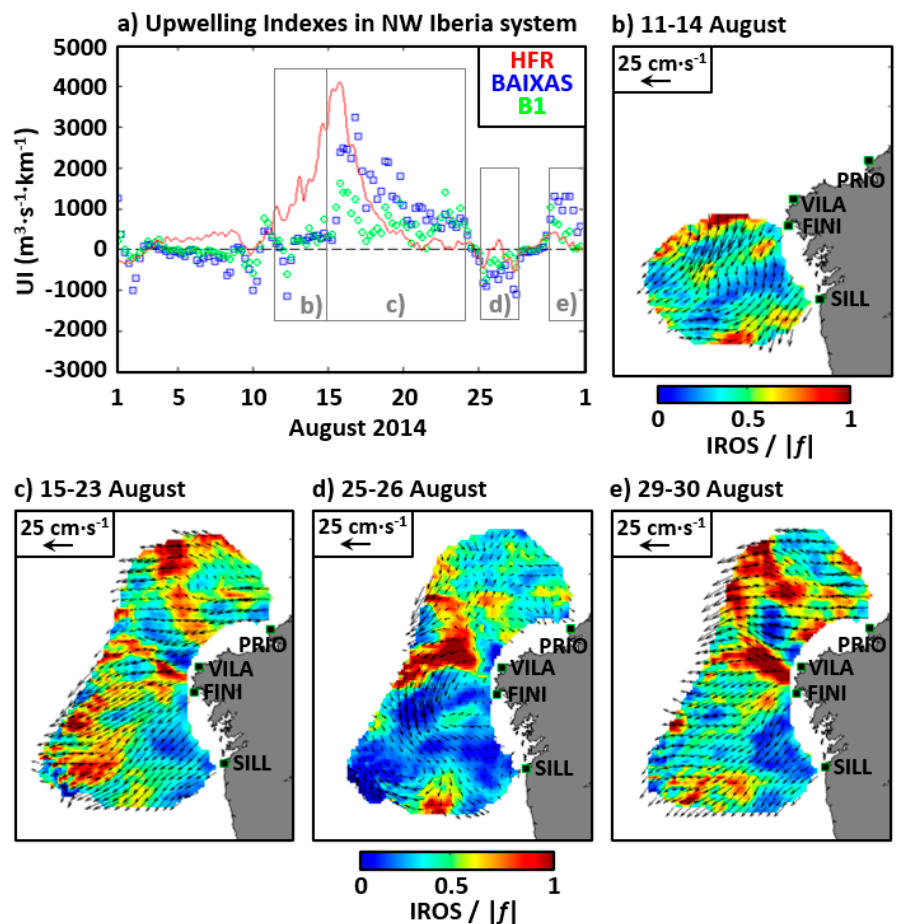
Figure 13. ( a ) Temporal evolution of hourly UI HFR (red line) and six-hourly UI BAIXAS (blue squares) and UI B1 (green dots) during August 2014. Gray boxes indicate four selected UPW and DOW episodes. ( b – e ) Maps of time-averaged circulation and Instantaneous Rate of Separation (IROS) for each specific event. IROS magnitudes are normalized by the absolute value of the Coriolis parameter, f .